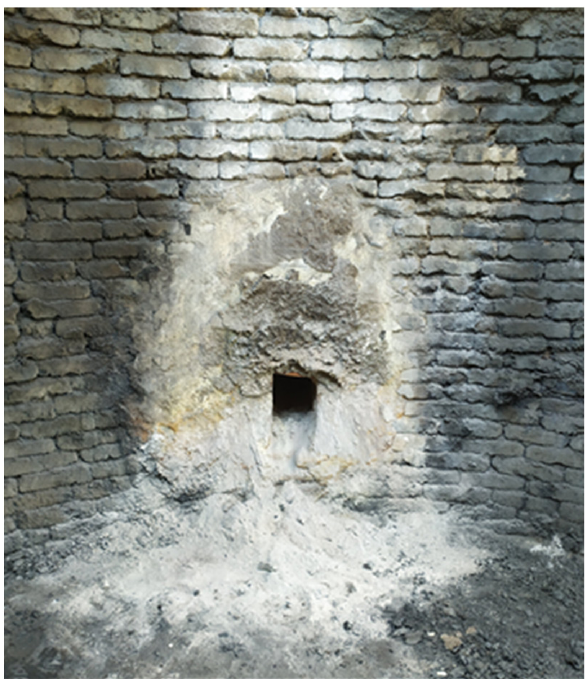
Figure 3. Ash deposition around the gas outlet duct leading to chimney S2 as observed during the kiln discharge procedure following carbonization Test 1.